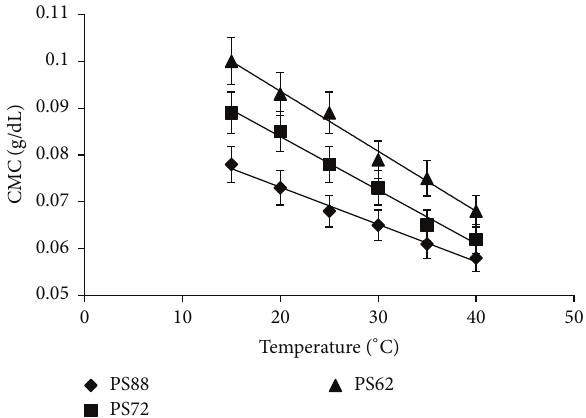
Figure 4: CMC of various polymer samples as a function of tem-